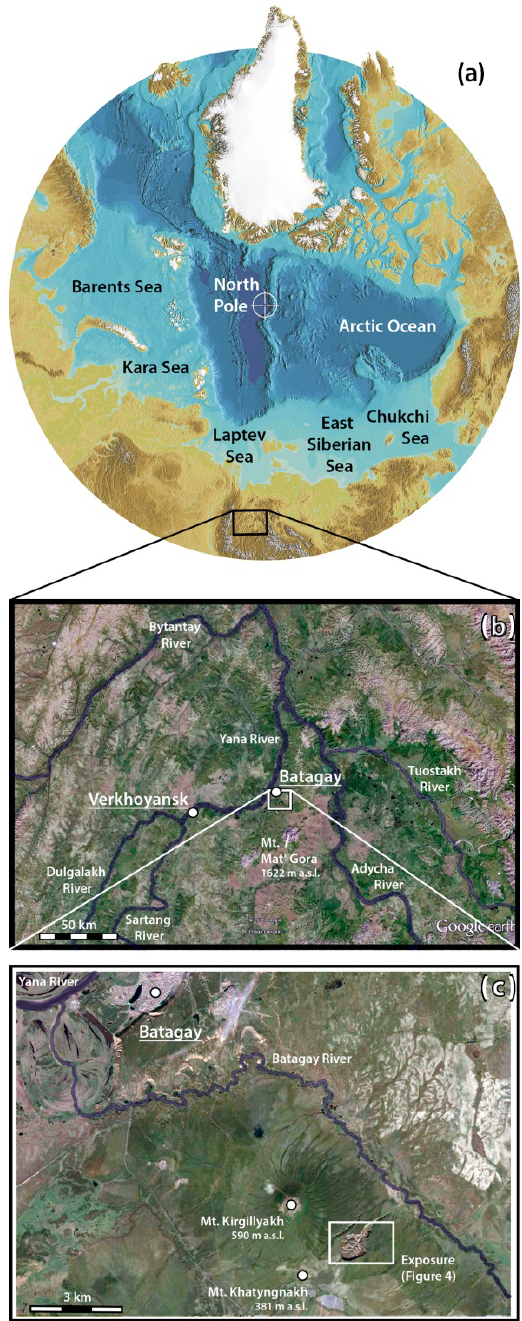
Figure 1. (a) Location of the Yana Highlands in northeastern Siberia. Map modified from the International Bathymetric Chart of the Arctic Ocean (Jakobsson, 2012). (b) Location of the study area on the right southeastern bank of the Yana River valley. (c) Location of the Batagay mega-slump (framed) at the north- eastern slope of Mt. Khatyngnakh, left bank of the Batagay River. Panels (b) and (c) have been modified from satellite pictures, Google Earth 7.1.2.2041. Batagay region, Russia, 67 ◦ 34 (cid:48) 41.83 (cid:48)(cid:48) N, 134 ◦ 45 (cid:48) 46.91 (cid:48)(cid:48) E, 4 July 2013, viewed 25 April 2016, http://www.